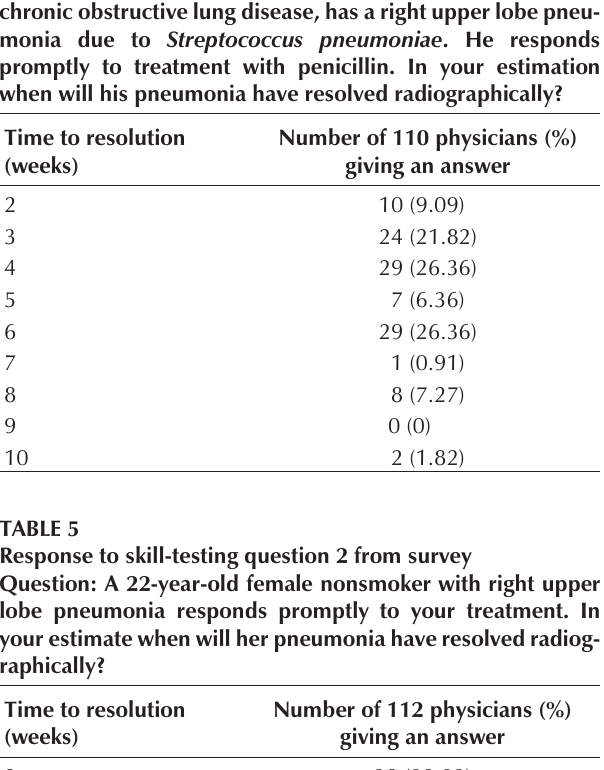
Factors that physicians (n=114) considered important in their decision to perform a chest radiograph on a patient with